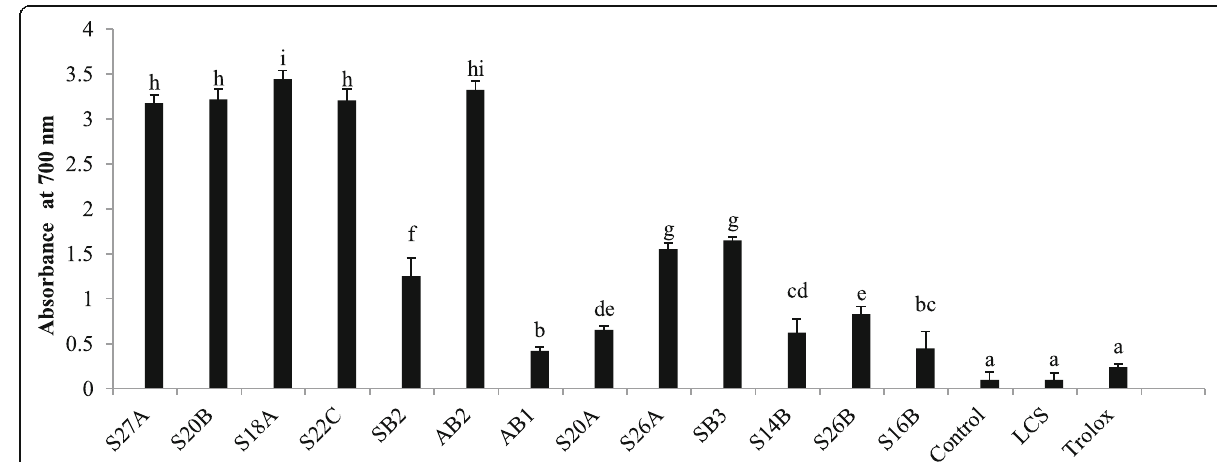
Fig. 4 Total reducing power of Enterococcus strains cell-free supernatant by FRAP assay. The reduction activity of cell-free supernatants was measured by absorbance at 700 nm and compared with Trolox, a synthetic antioxidant. Columns with different letters are significantly different p <